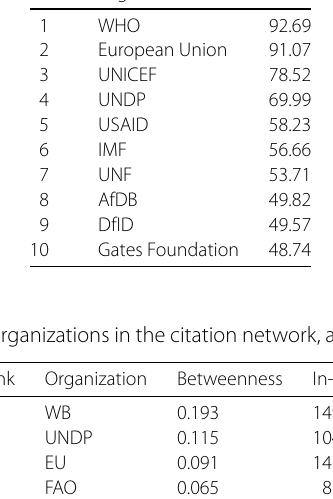
Table 1 Top ten organizations according to WS for the World Bank in the co-citation network Rank Organization WS 1 WHO